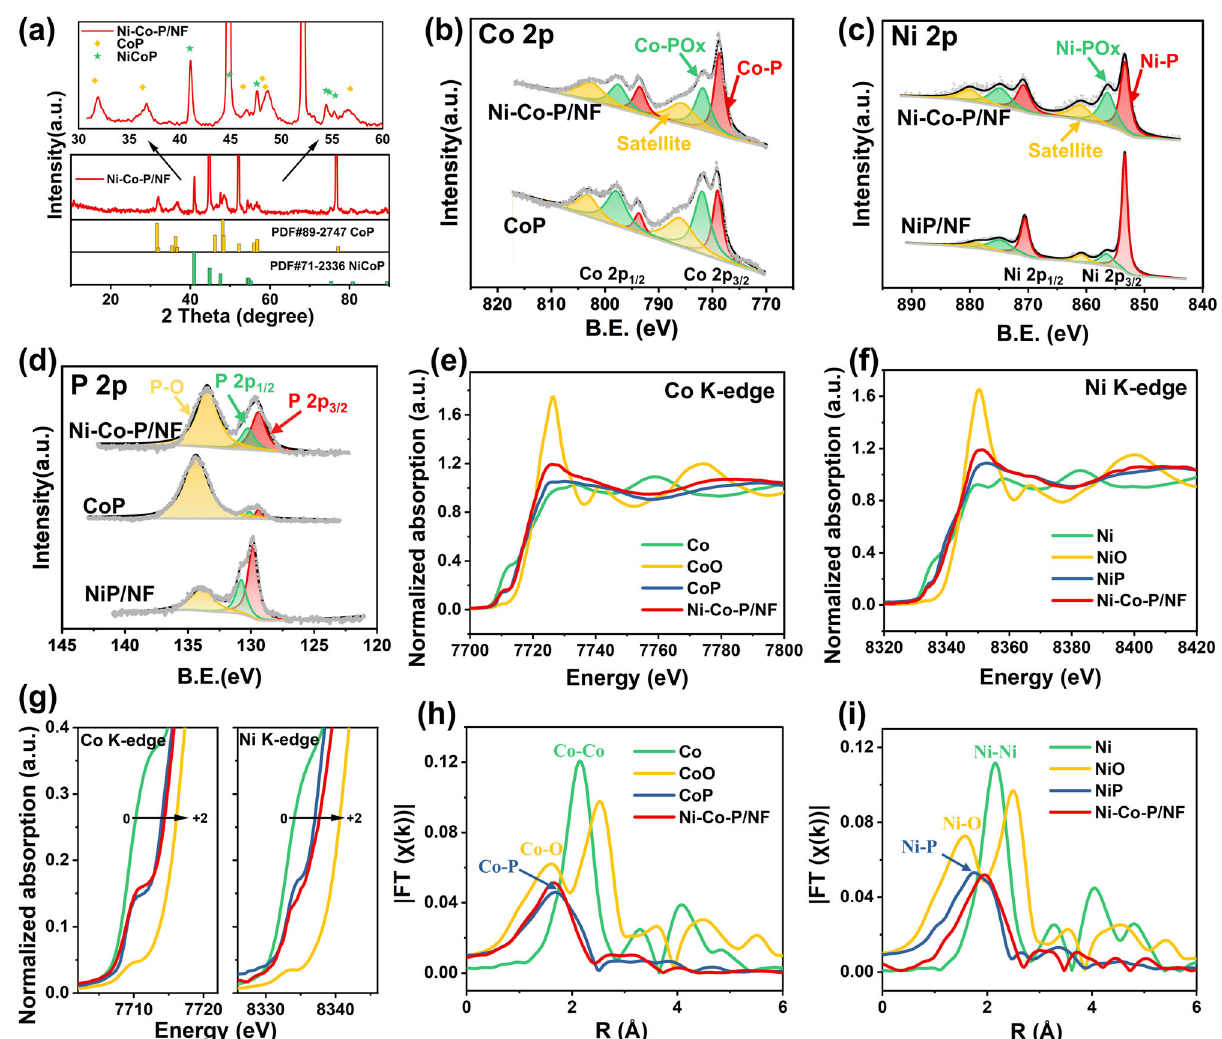
Fig.2|StructuralcharacterizationsofNi-Co-P/NFandreferencesamples.a XRD patterns of Ni-Co-P/NF; High-resolution XPS spectra of b Co 2p; c Ni 2p; d P 2p for the prepared samples; e Co and f Ni K-edge XANES spectra of Ni-Co-P/NF and the